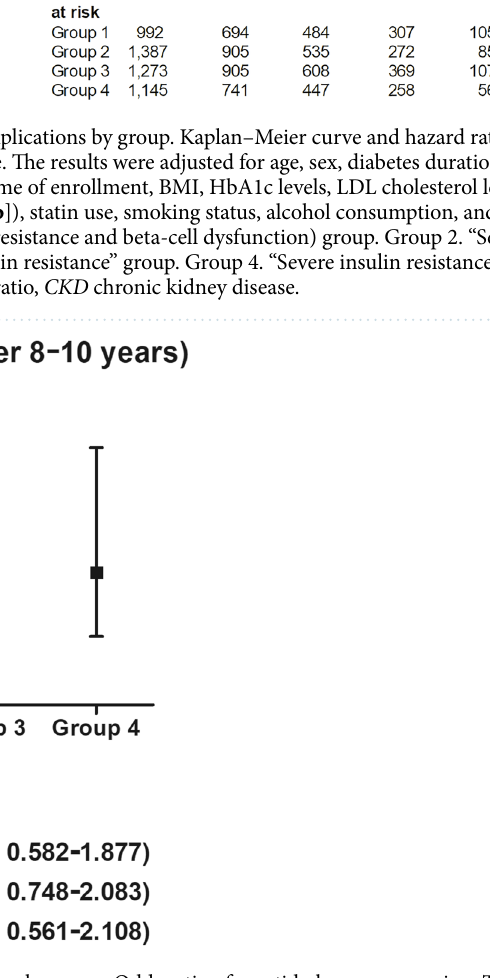
Figure 3. Risk of carotid plaque progression by group. Odds ratio of carotid plaque progression. The results were adjusted for age, sex, diabetes duration, systolic blood pressure, diastolic blood pressure, time of enrollment, BMI, HbA1c levels, LDL cholesterol levels, eGFR, statin use, smoking status, alcohol consumption, and physical activity. Group 1. Reference (mild insulin resistance and beta-cell dysfunction) group. Group 2. “Severe beta-cell dysfunction” group. Group 3. “Severe insulin resistance” group. Group 4. “Severe insulin resistance and beta-cell dysfunction” group. aOR adjusted odds